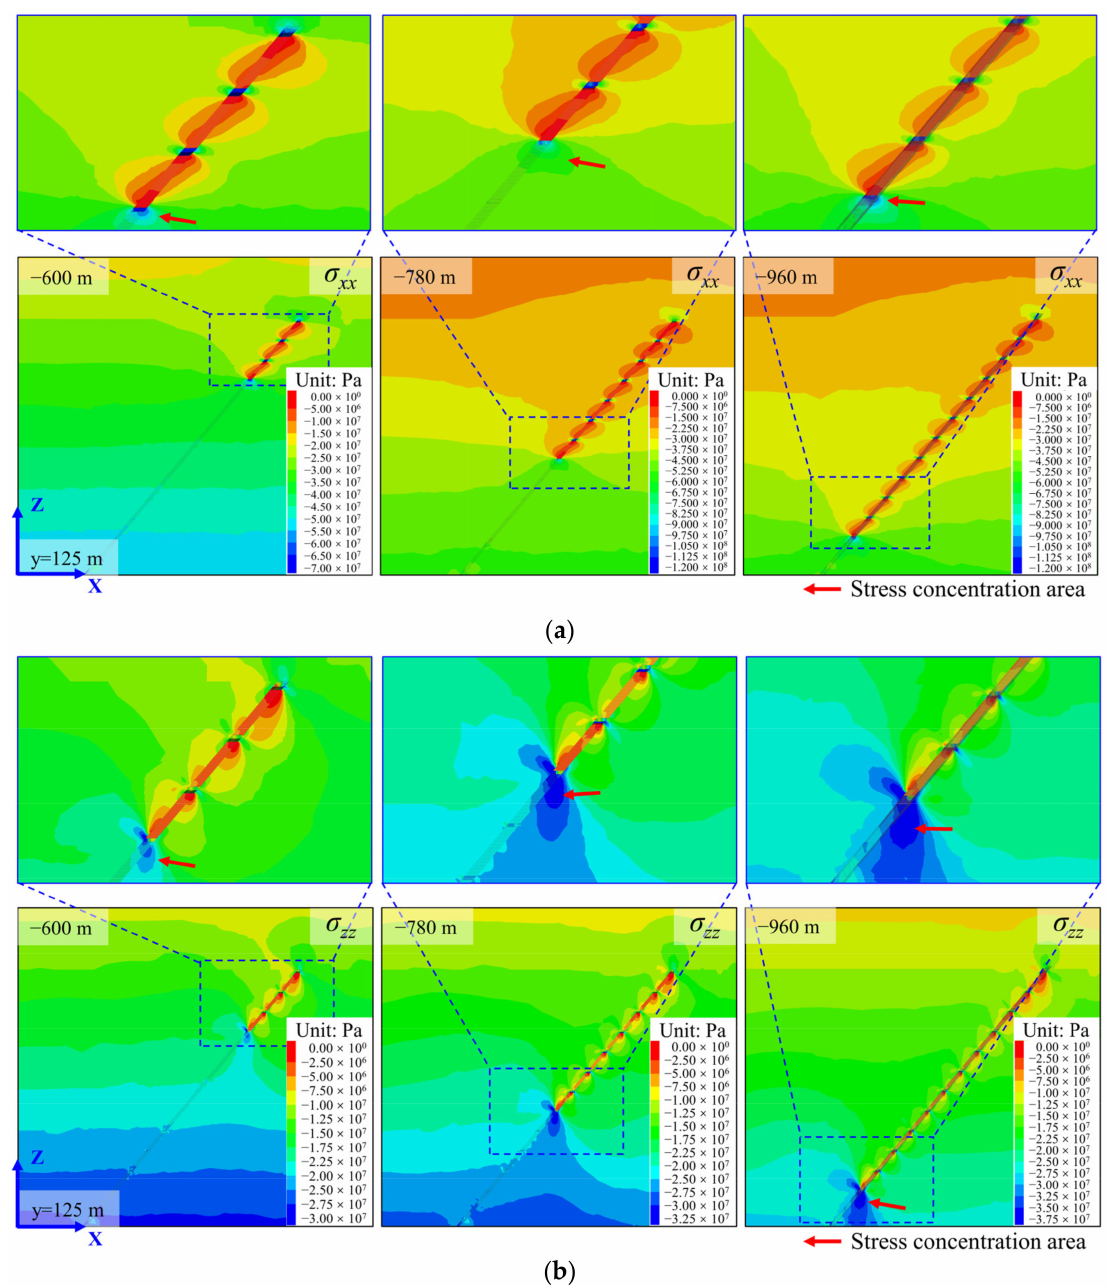
Figure 6. Stress distribution along the stope’s midline (y = 125 m) (tensile stress is positive). ( a ) Hori- zontal stress distribution, σ xx ; ( b ) Vertical stress distribution, σ zz